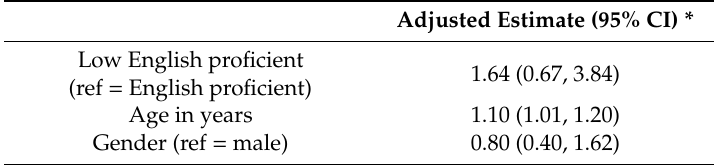
Table 3. Opioid administration (in OME per kilogram) in the PACU, by English proficiency.